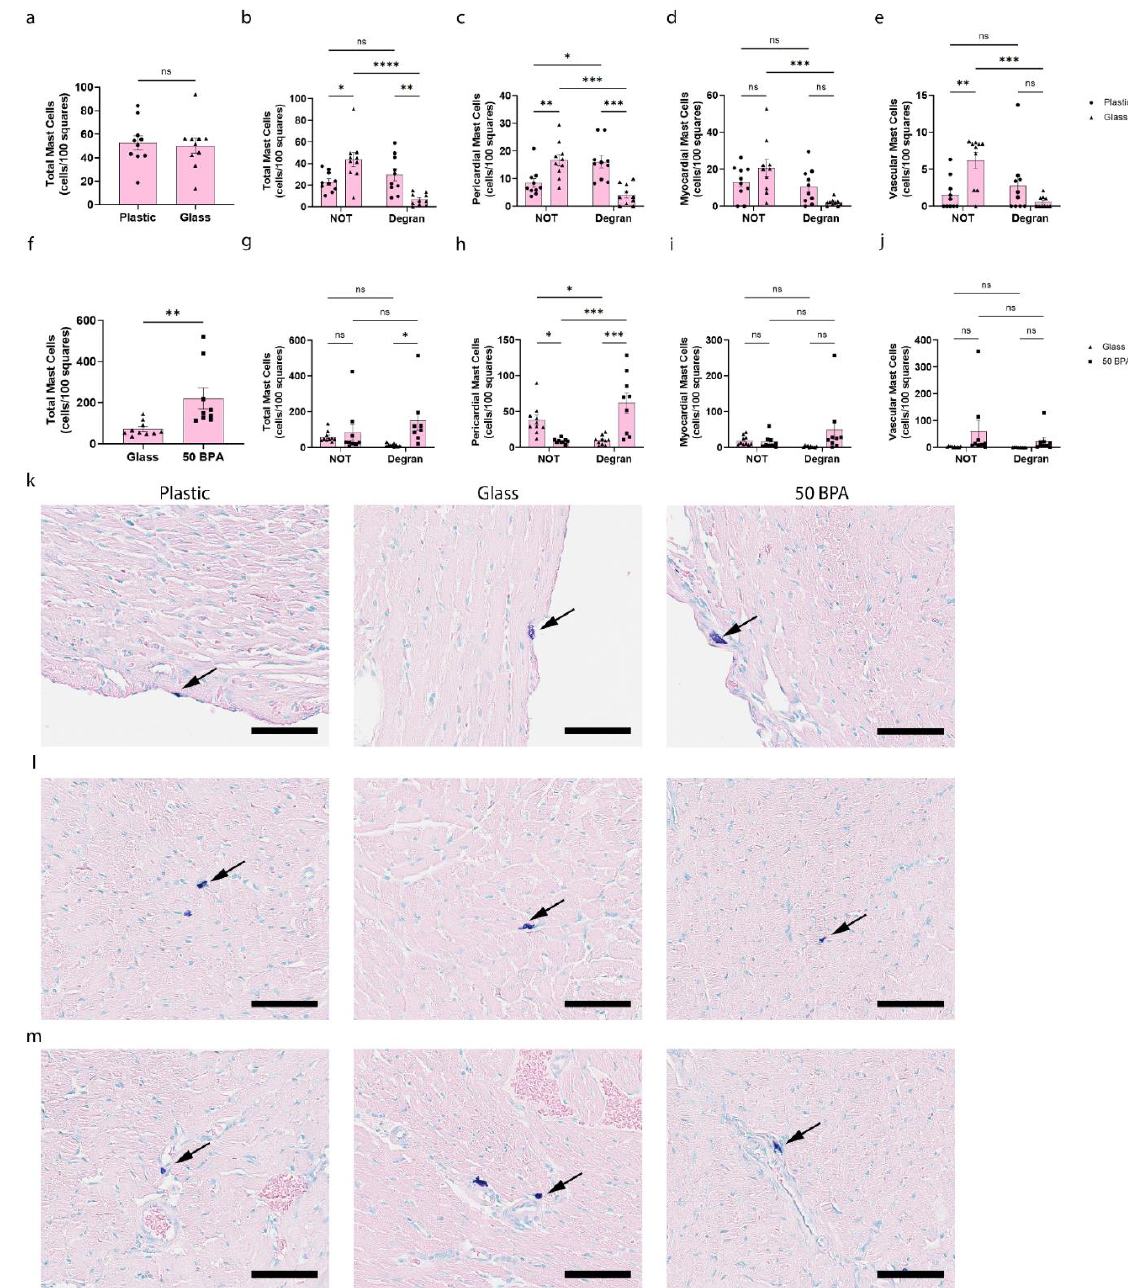
Figure 7. Plastic caging increases pericardial mast cell numbers and degranulation in females during myocarditis. Female BALB/c mice (pink) were given ( a – e ) normal drinking water (drinking water that did not contain BPA) for 2 weeks and housed either in glass cages/water bottles (glass) or plastic cages/water bottles (plastic) with soy-free food and bedding. ( f – j ) BALB/c mice housed in glass cages/water bottles with soy-free food and bedding were given either normal drinking water (drinking water that did not contain BPA) (glass) or 250 μ g BPA/L water (50 BPA) for 2 weeks. Mice were injected i.p. with 10 3 PFU of CVB3 on day 0 and harvested at day 10 pi. Mast cell scoring was completed using the 40× high-power objective on a compound microscope. Mast cells were counted and categorized according to whether they were degranulated or not and by their location as pericardial, myocardial or near vessels. Data shown as scatter plot and mean +/ − SEM using a Student’s t -test with 9–10 mice/group (* p < 0.05), (** p < 0.01), (*** p < 0.001), (**** p < 0.0001). Representative histology images of mast cells (purple, arrow). Representative images in plastic caging (plastic), glass caging (glass), or 50 BPA in drinking water (50 BPA) in glass cages show mast cells associated with the ( k ) pericardium, ( l ) myocardium or ( m ) vessels (magnification 400 × , scale bar 60 µ